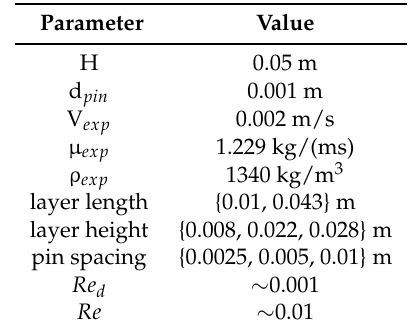
Table 3. Parameters used in the physical model